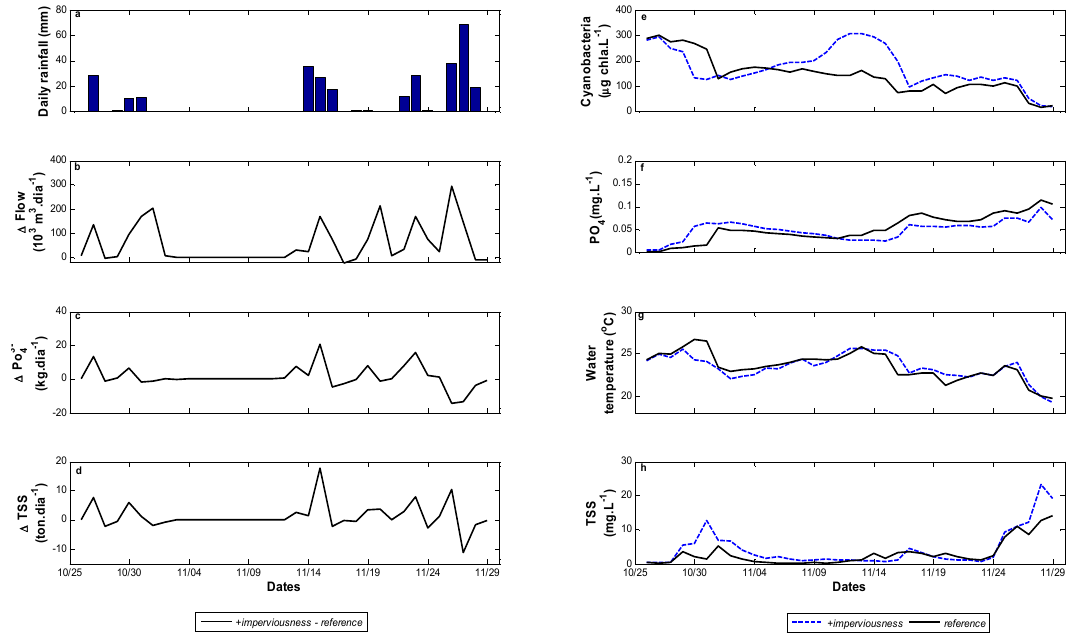
Figure 11. From 25 October to 29 November 2011: ( a ) Daily rainfall in Lake Pampulha catchment; difference between +imperviousness and reference scenarios for daily flow ( b ); daily PO 43- load ( c ); daily TSS load ( d ); mean value (averaged from 0 to 2.5 m depth) in Lake Pampulha for scenarios reference (black continuous line) and +imperviousness (dotted blue line) of ( e ) cyanobacteria biomass; ( f ) PO 43- concentration; ( g ) water temperature and; ( h ) TSS concentration.